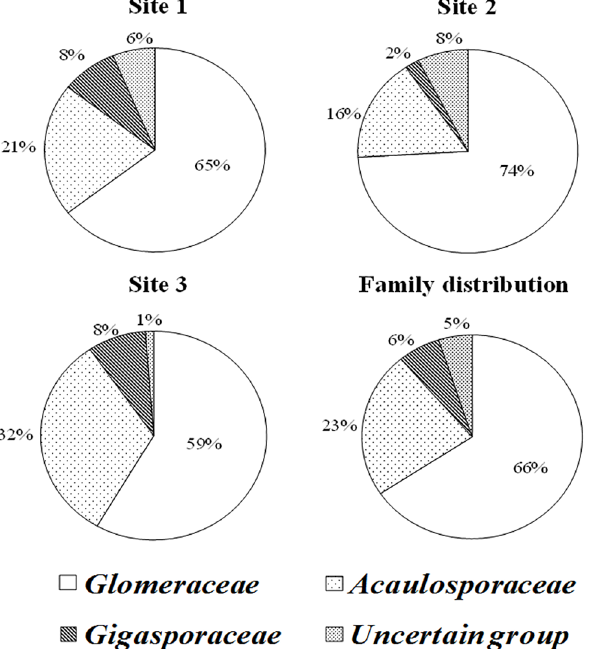
Fig 1. Family relative abundance (FRA) of arbuscular mycorrhizal fungi in heavy metal contaminated soils.